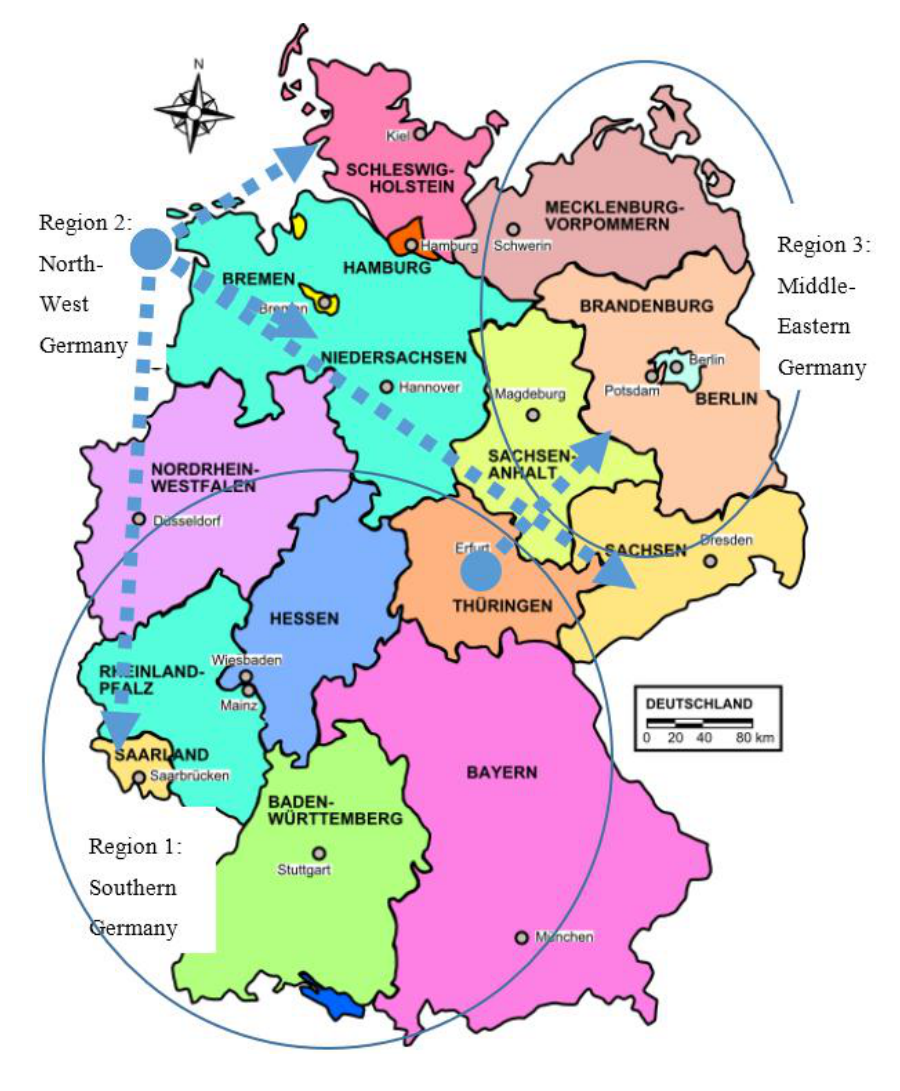
Figure 4. Germany and its three sub-regions for harvester sizes depending on farm size and field size. Source: [15]; own assumptions and